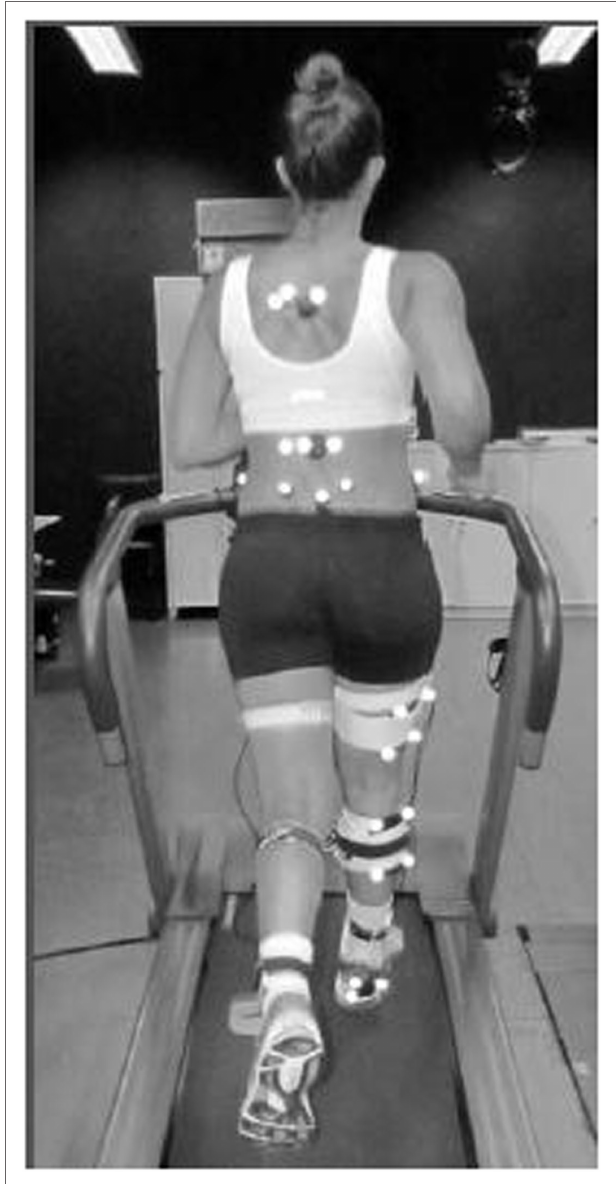
FIGURE 1 | Subject running on a treadmill with the reflective markers (little white circles) in the trunk, hip, knee, and ankle during a kinematic data collection